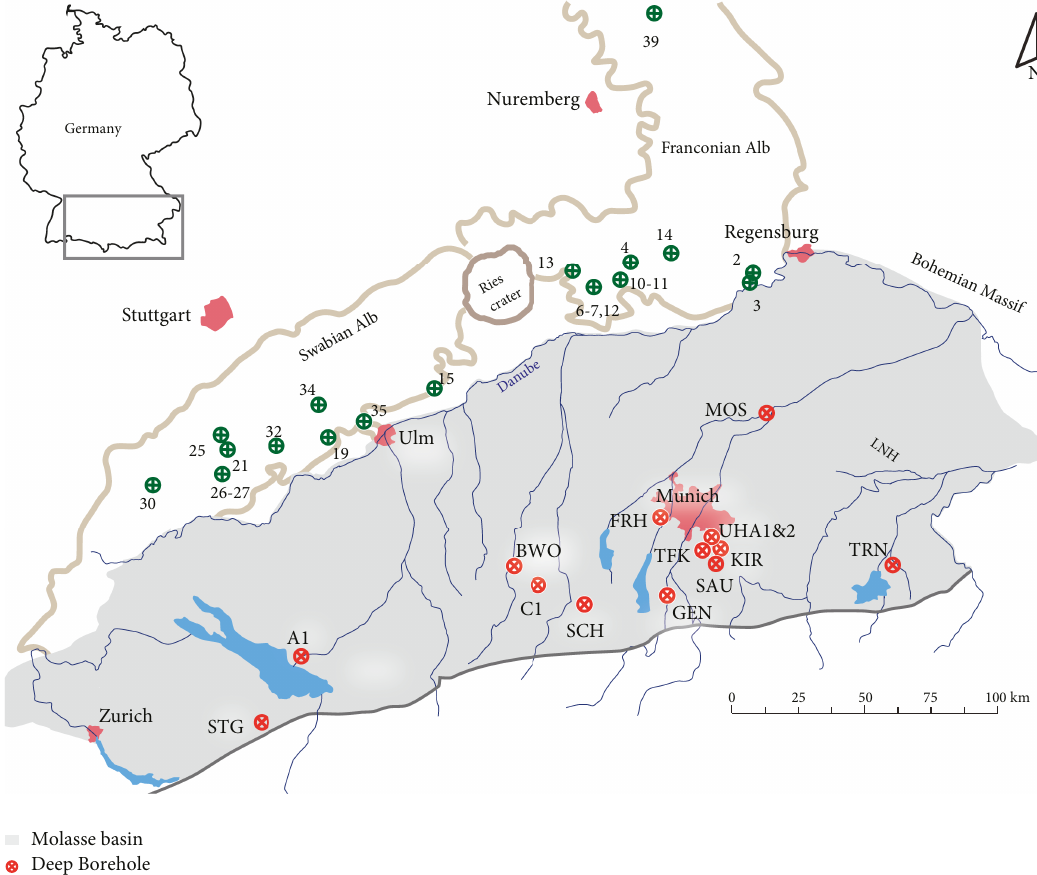
Figure 1: Overview of the study area in the Molasse Basin, southern Germany and eastern Switzerland. FRH: Freiham; GEN: Geretsried; KIR: Kirchstockach; MOS Moosburg; SAU Sauerlach; TFK Taufkirchen; TRN: Traunreut; UHA: Unterhaching; SCH: Schongau; STG: St. Gallen; BWO: Bad Woerishofen, outcrops according to Table 1.